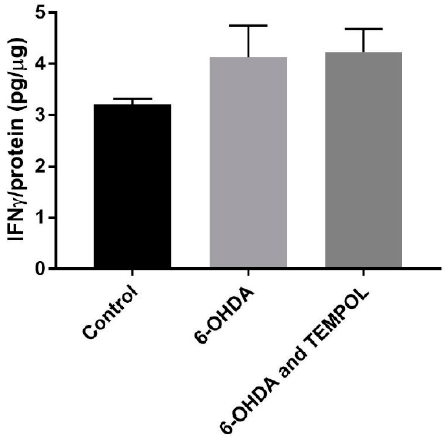
Figure 8. Change in IFN γ protein expression in cultured SH-SY5Y dopaminergic cells after treatment with 6-OHDA ± TEMPOL. Change in IFN γ protein expression in SH-SY5Y cells in response to treatment with 30 μ M 6-OHDA ± 30 μ M TEMPOL assessed with a commercial ELISA kit. Data was normalised to total sample protein and shown as mean ± SEM, n = 4 independent experiments.